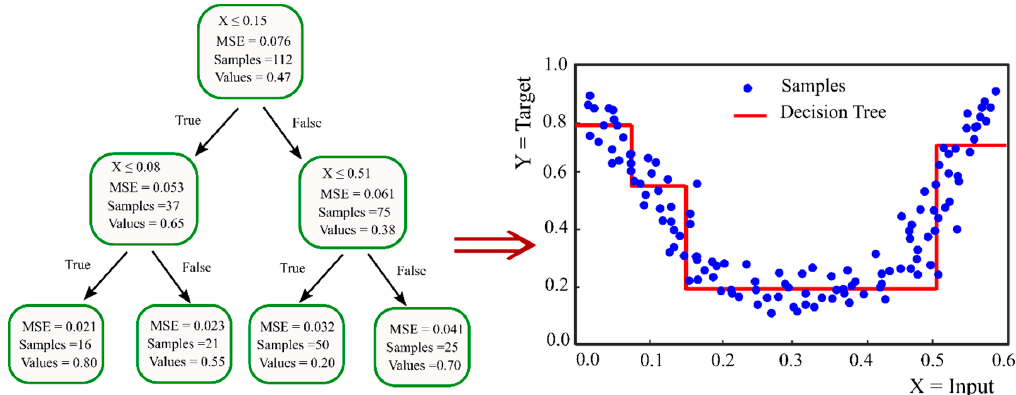
Figure 3. Examples of using a decision tree for regression.